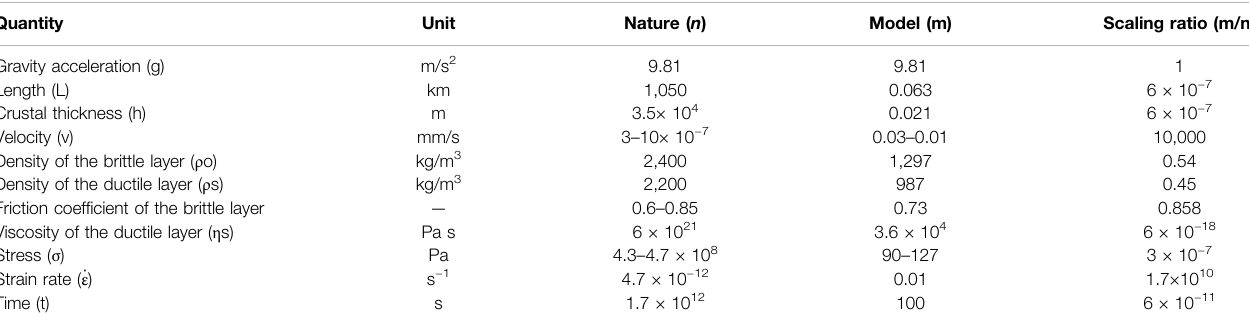
TABLE 2 | Material properties and scaling parameters between the model and nature. Quantity Unit Nature ( n